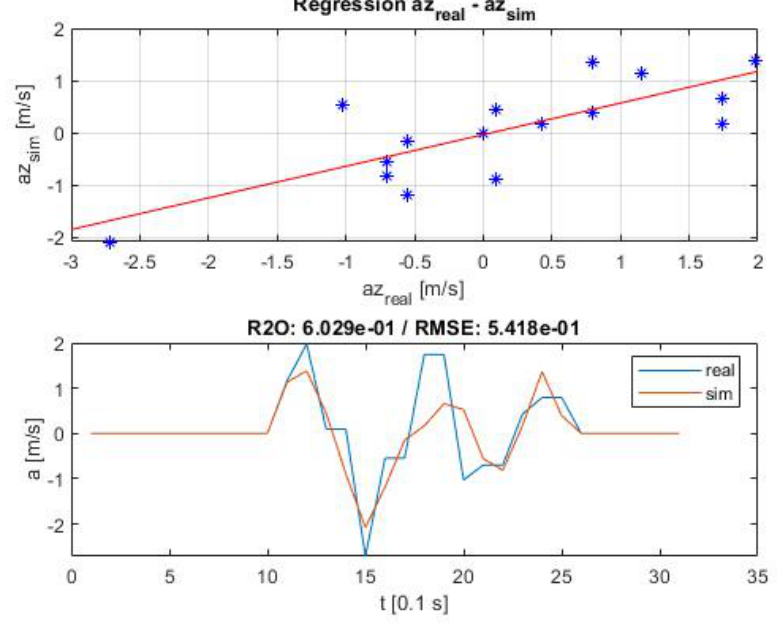
Figure A2. Validation of the z -acceleration in scenario 2 including ordinary R 2 and RMSE